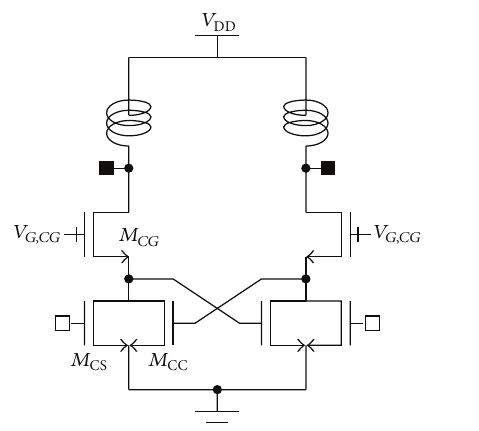
Figure 4: Proposed mode-locking technique for the cascode struc- ture.